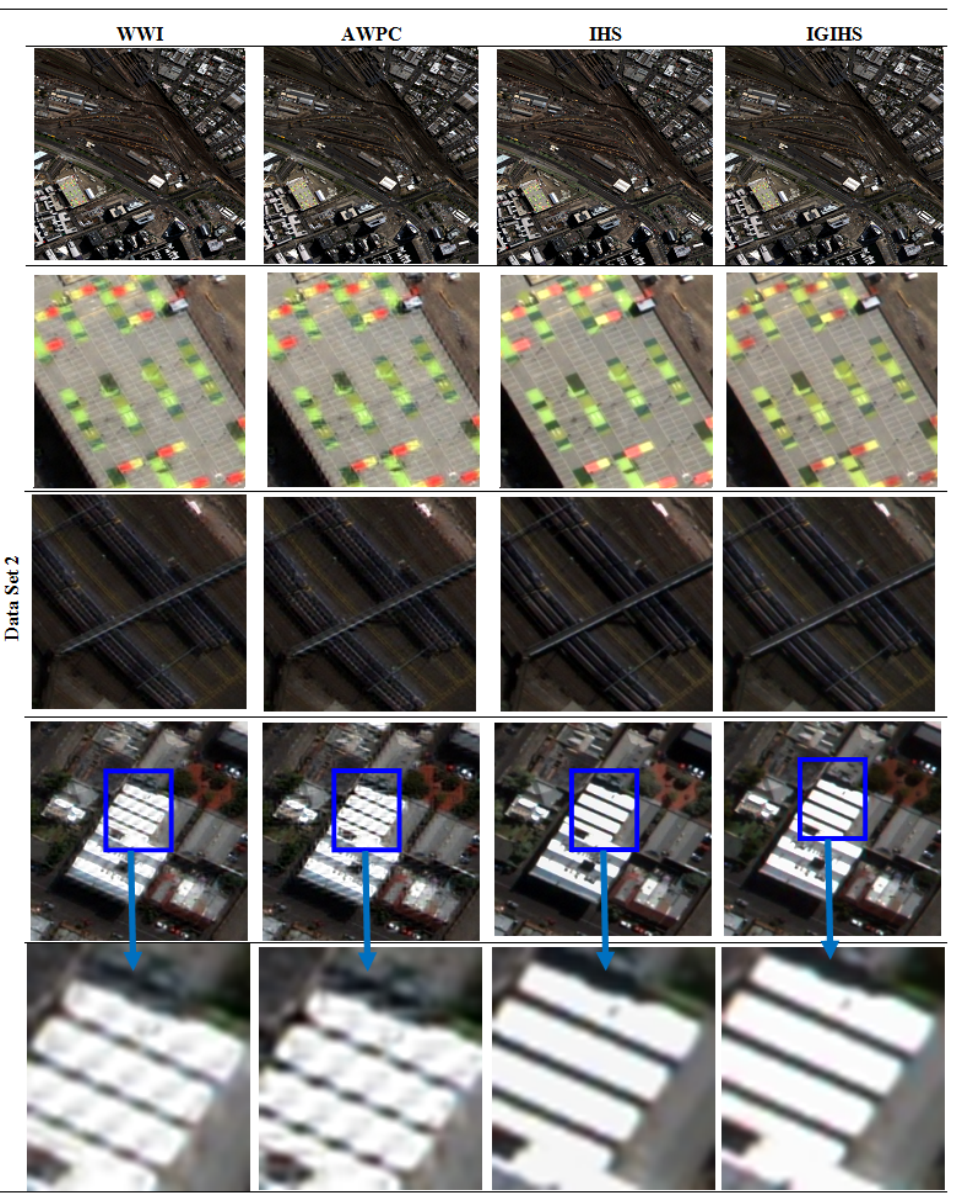
Figure 5. Pan-sharpening results, data set